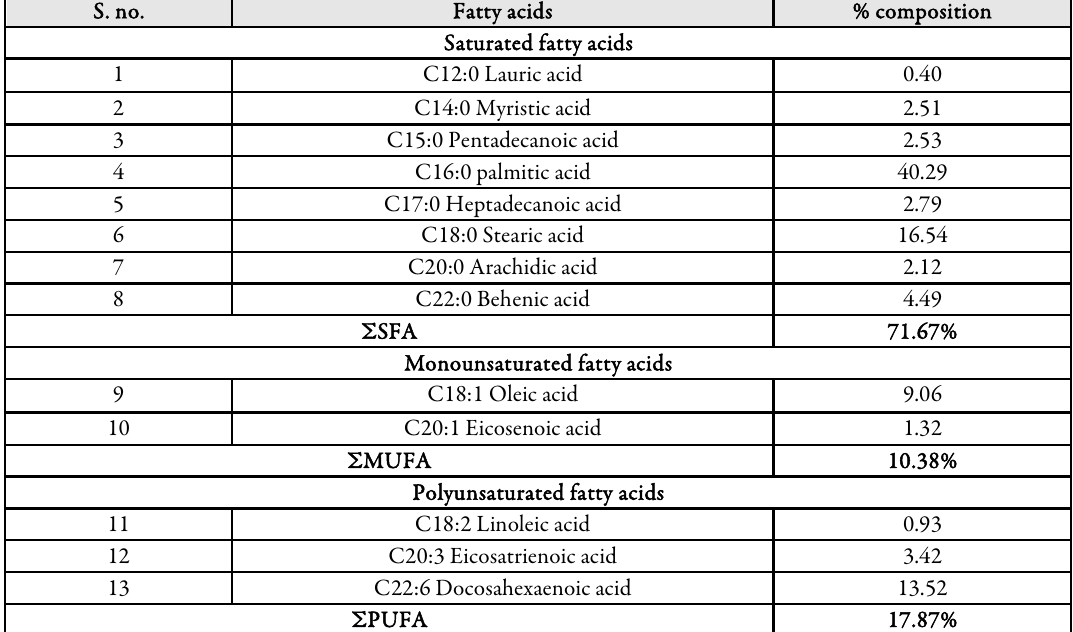
Table 3. Fatty acid composition of S.